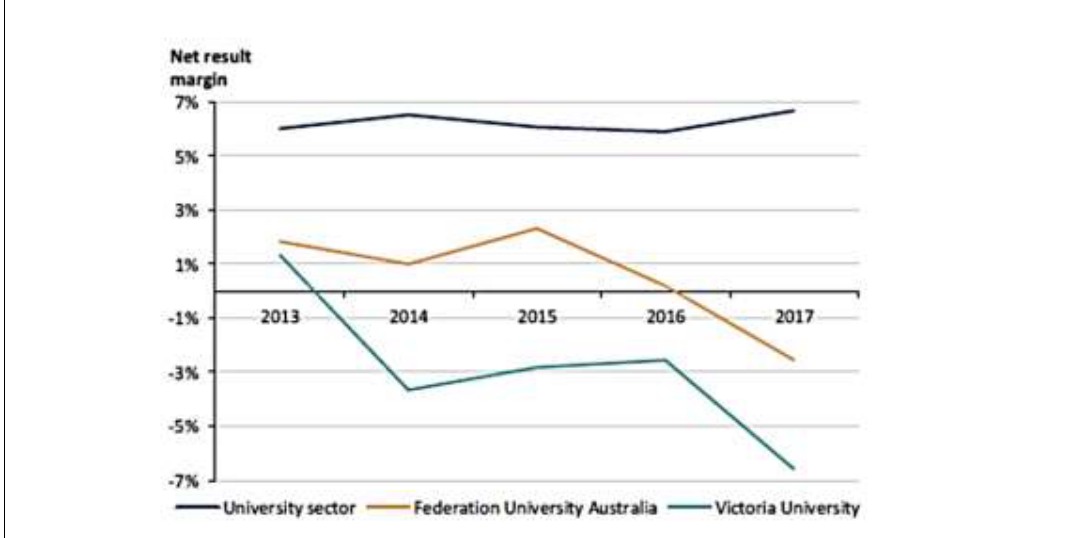
Figure 1. Victorian Auditor-General analysis of financial performance of universities in